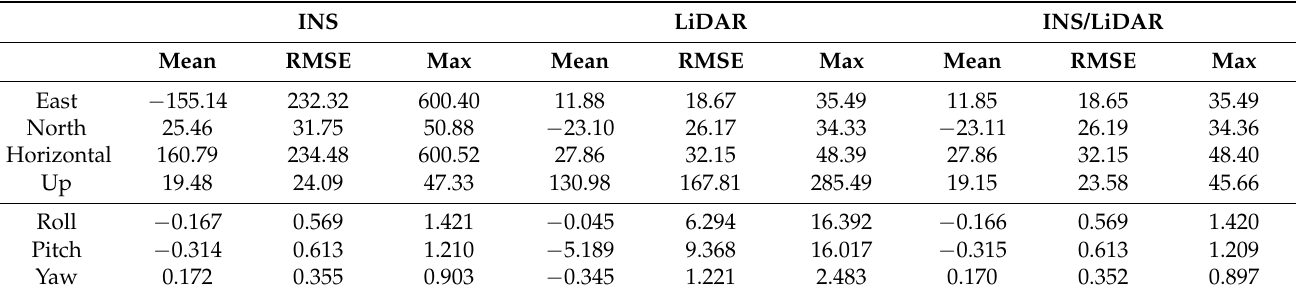
Table 5. D-42—position (m) and attitude (deg) error statistics.